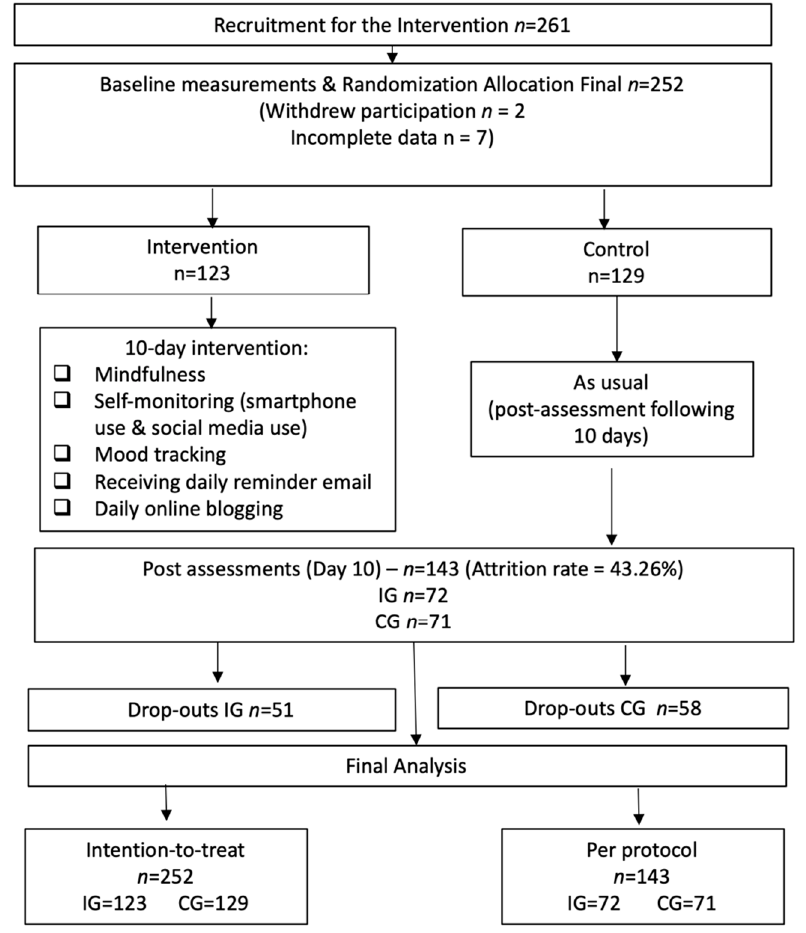
Figure 1. Participant flow in the intervention.